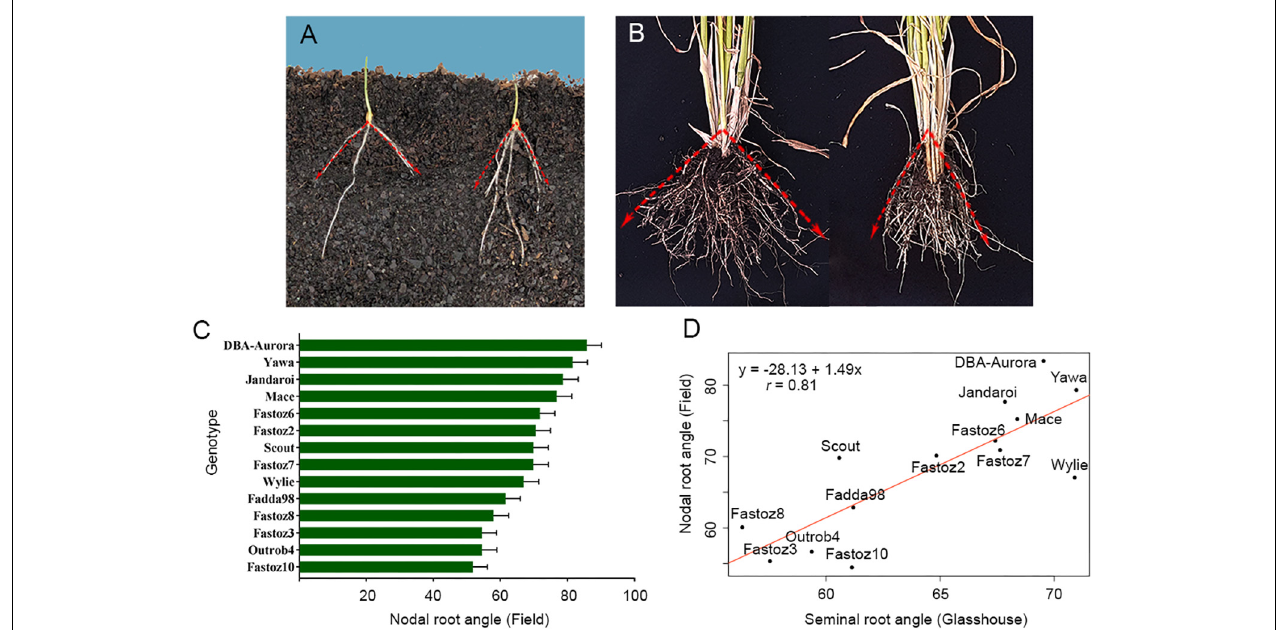
FIGURE 2 | Root growth angle phenotypes measured in important durum wheat cultivars from Australia and ICARDA: (A) seminal root angle for Australian variety DBA Aurora (left, wide root angle) and an ICARDA elite founder line Outrob4 (right, narrow root angle) screened using the clear pot method, and (B) in the field using shovelomics method. (C) Nodal Root growth angle field measurements of 14 parental lines used for NAM population development. Correlation between seminal root angle in the glasshouse and mature roots in the field, r = 0.81, P = 0.00038 (D) .